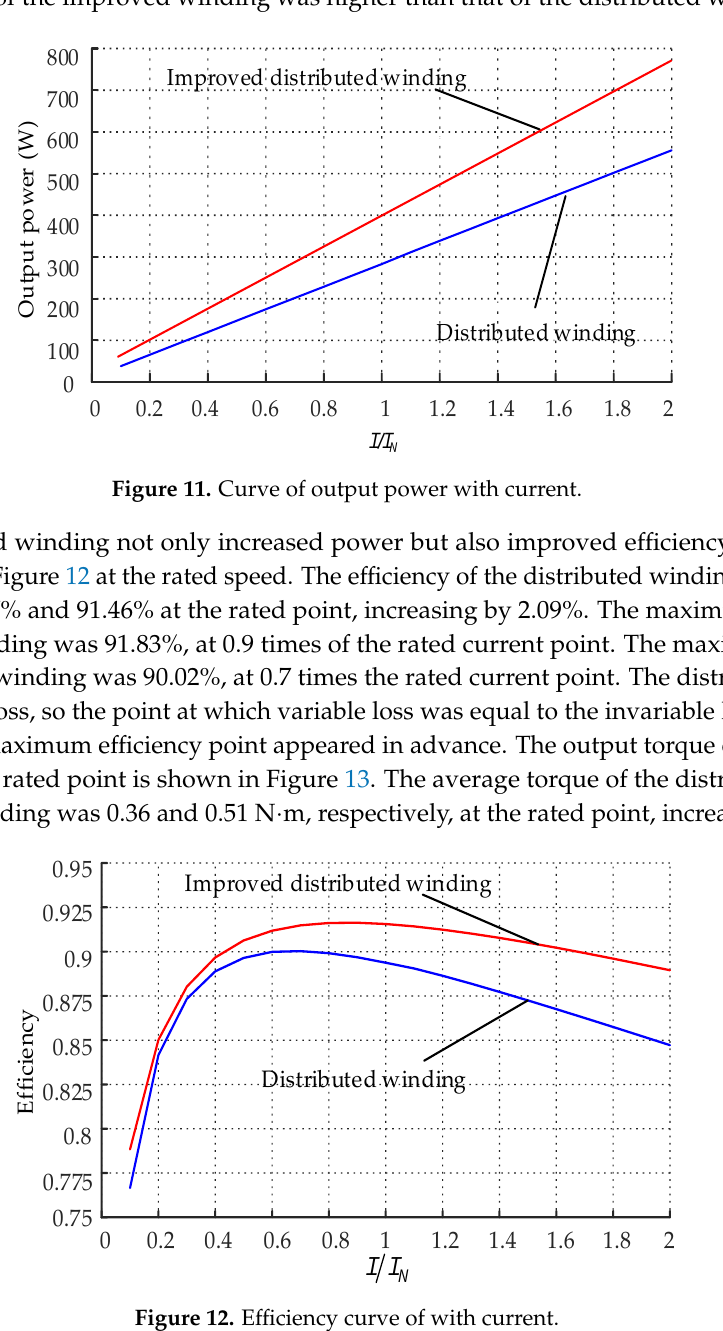
Figure 12. Efficiency curve of with current.